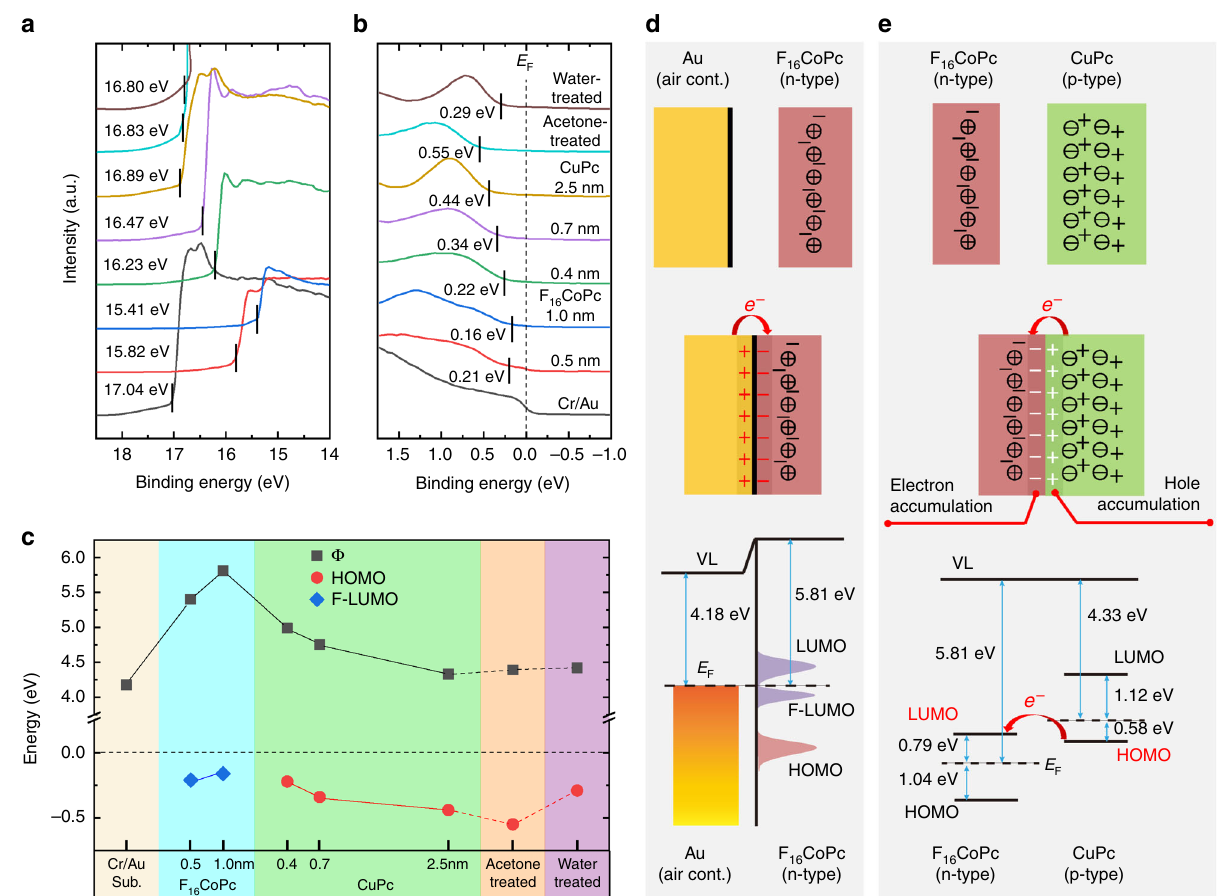
Fig. 2 Carrier transfer among bottom Au/F 16 CoPc/CuPc. a , b UPS spectra (He – I α = 21.22 eV) corresponding to cut-off and HOMO (or VB) regions of the Au/F 16 CoPc/CuPc system. c Evolution of work function ( Φ ) and HOMO peak edges with respect to the Fermi level ( E F ) of the Cr/Au substrate. d , e Schematic diagrams of charge transfer between Au substrate and 1 nm F 16 CoPc, and between n-type F 16 CoPc and p-type CuPc ( + / − : free carriers, ⊕ / ⊝ : charge